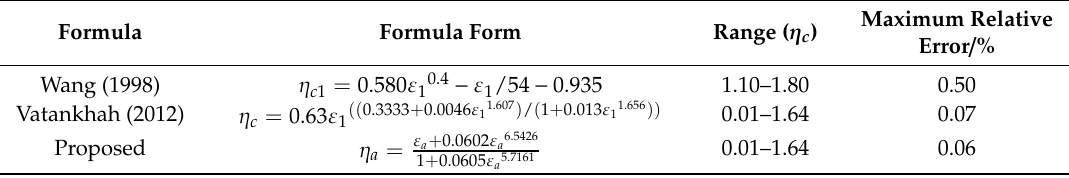
Table 3. The comparison of different formulas for the critical depth of standard arched sections.